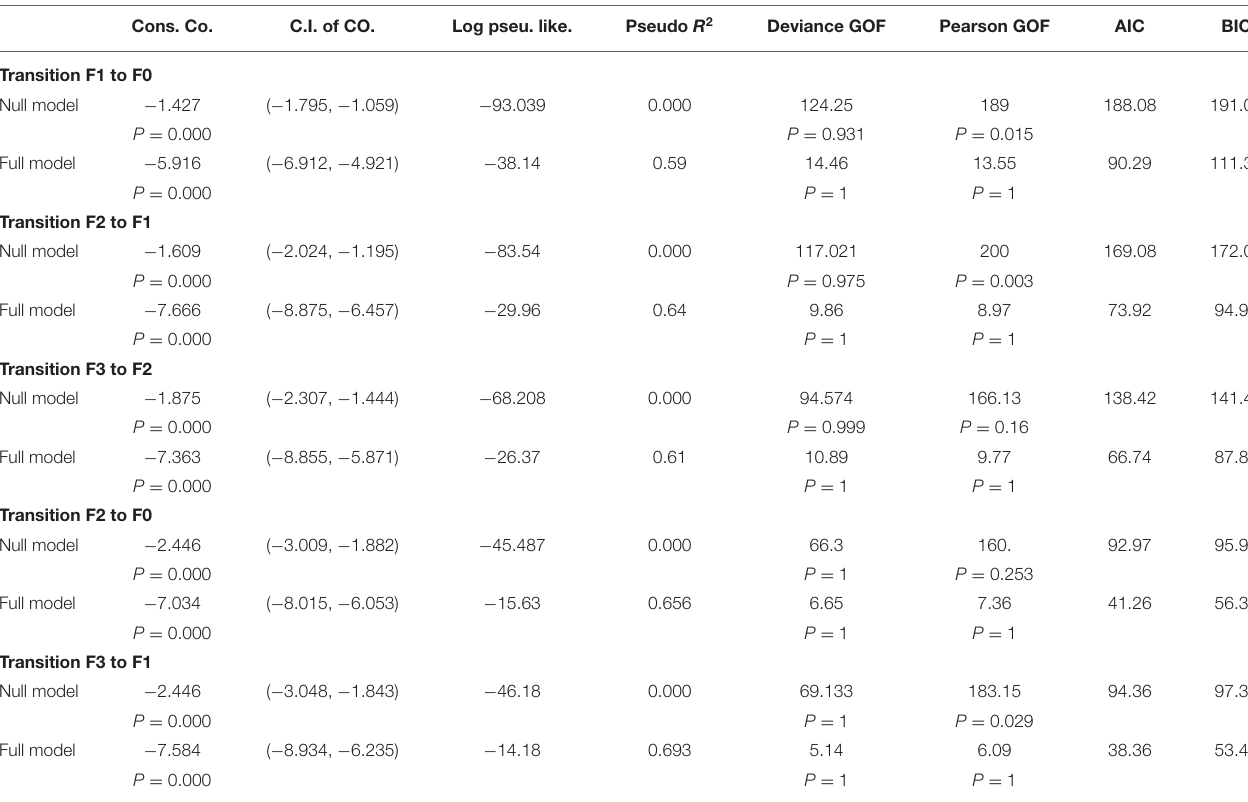
TABLE 7 | Comparison between null and full model as regards the regressive transitions. Cons.